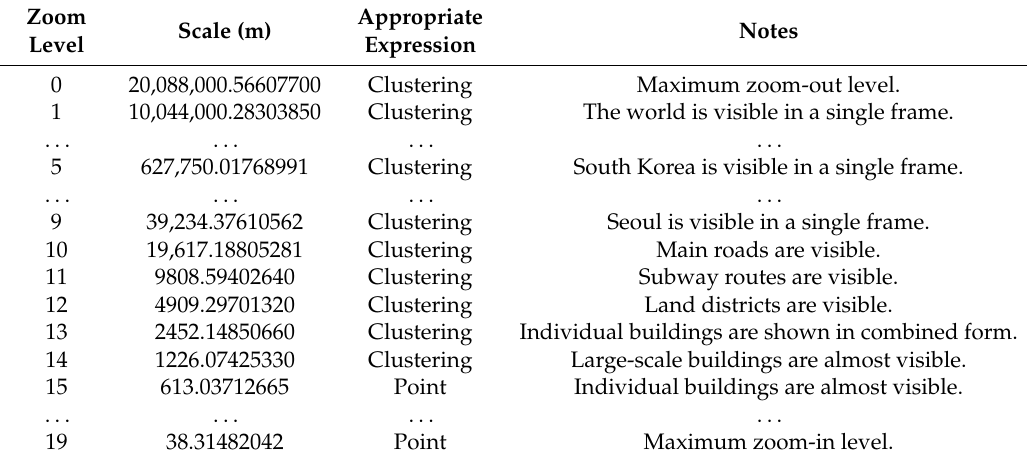
Table 1. Scales of Google maps according to zoom